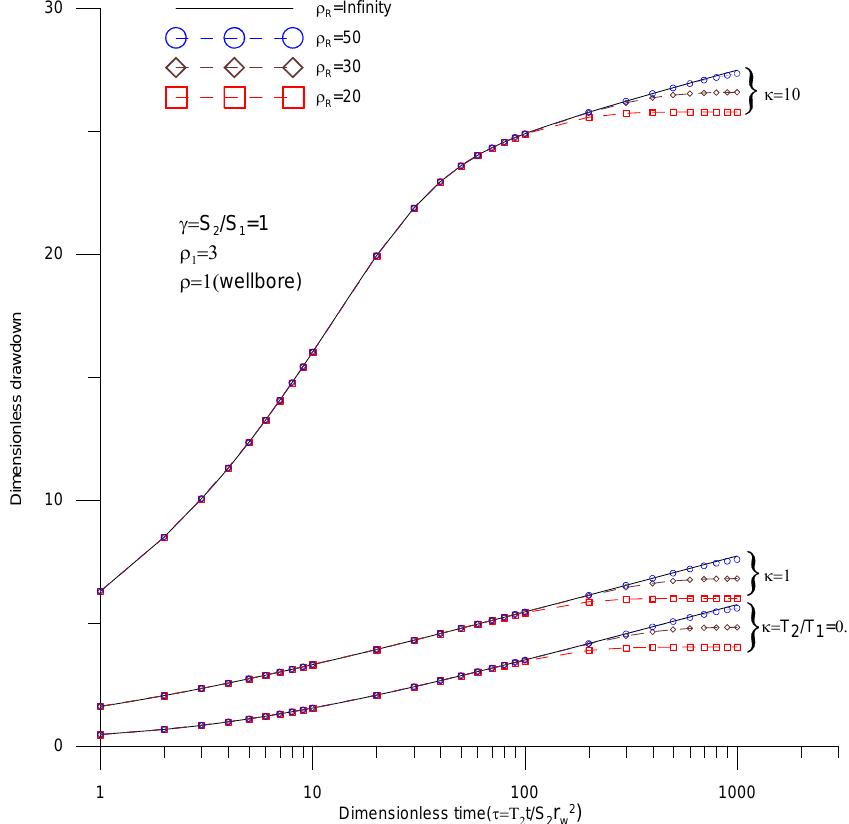
Fig. 2. The predicted drawdown curves at ρ = 1 ( wellbore) for infinite aquifers denoted by the solid line and for finite aquifers having the outer boundary distances of 20, 30, and 50 represented by the dashed lines with the symbols of circle, diamond, and square, respectively, for ρ 1 =3, γ =1 and κ =0.1, 1 and 10.